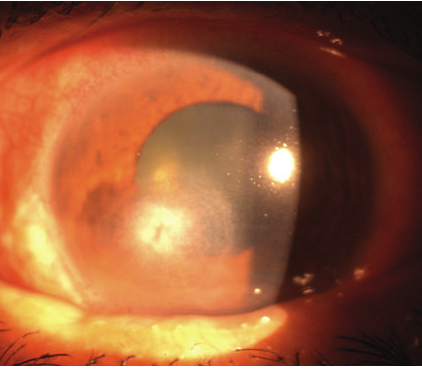
Figure 5: Day 22 sinceinitial examination (Day 11on Voriconazole).